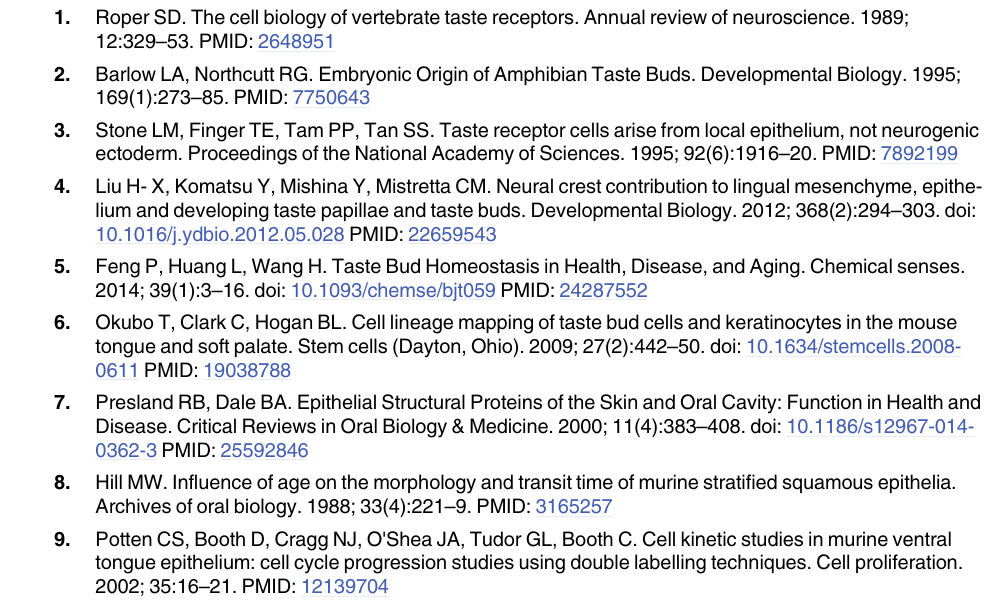
S2 Table. Primary and secondary antibodies used for